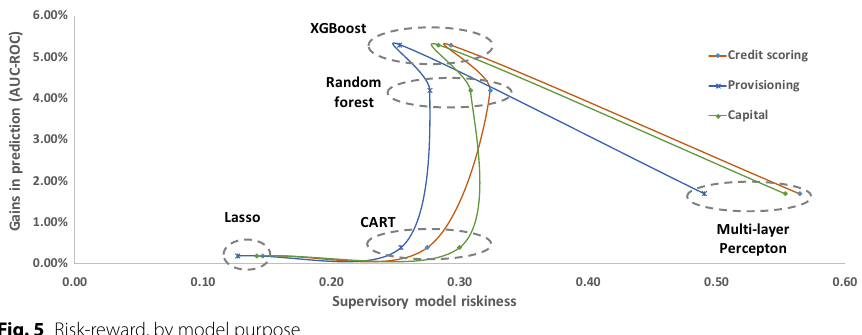
Fig. 5 Risk-reward, by model